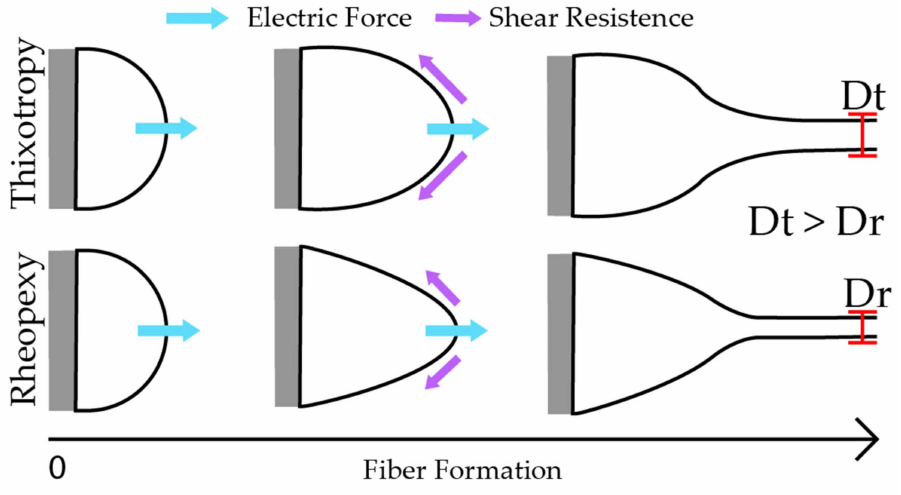
Figure 5. Taylor cone deformation according to the rheology properties. Thixotropic behavior leads to thicker fibers when compared with rheopetic